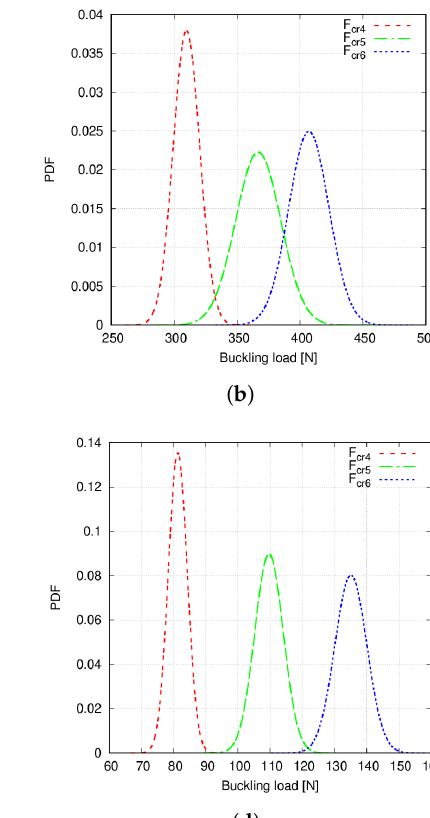
Figure 17. ( a ) Case 1 F cr 1 , F cr 2 and F cr 3 PDFs, ( b ) Case 1 F cr 4 , F cr 5 and F cr 6 PDFs. ( c ) Case 2 F cr 1 , F cr 2 and F cr 3 PDFs. ( d ) Case 2 F cr 4 , F cr 5 and F cr 6 PDFs. Fibre volume fraction is treated as a Gaussian random = 0.05 whereas misalignments have variable with mean value V f = 0.60 and standard deviation σ V f a null mean and standard deviation σ θ = 1.5 ◦ . As carried out in Section 5.2, mean value and standard deviation of each MAC matrix’s component are calculated and represented in Figure